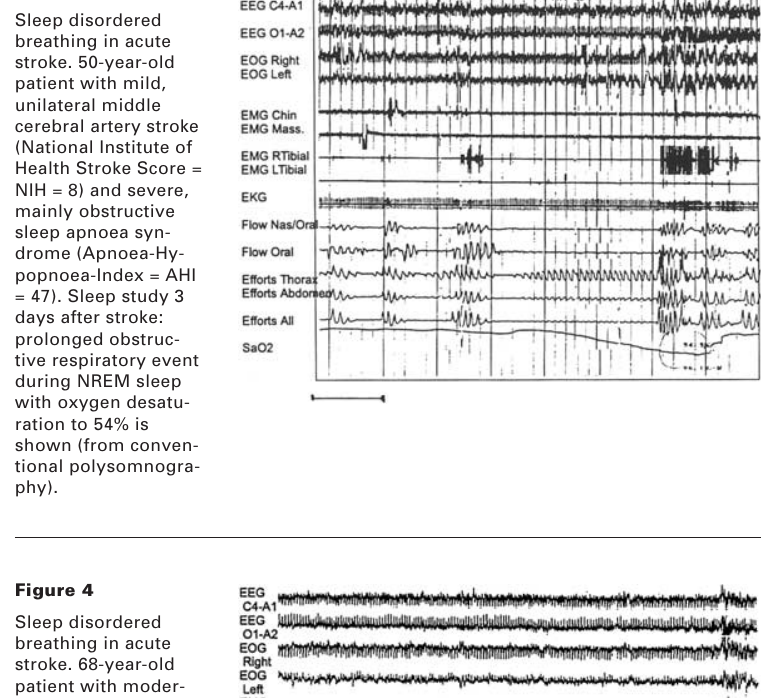
Sleep disordered breathing in acute stroke. 68-year-old patient with moder- ately severe, unilat- eral thalamo-mesen- cephalic stroke (NIH = 12) and severe, mainly central sleep apnoea syndrome (AHI = 45). Sleep studies 2 days after stroke (from conven- tional polysomnogra- phy) demonstrating the presence of cen- tral periodic